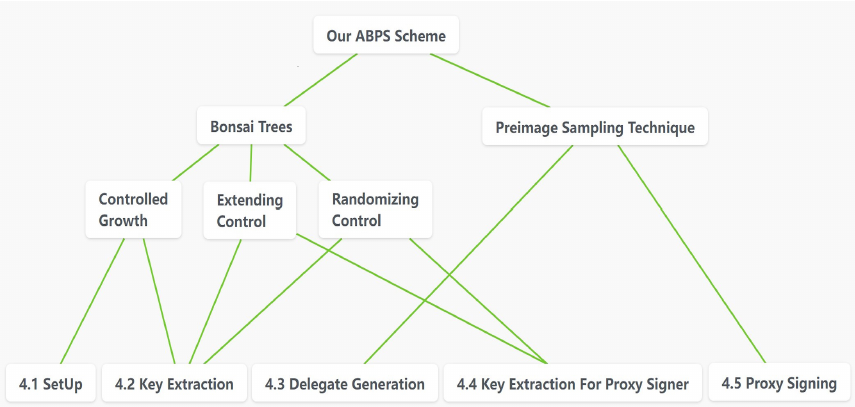
Figure 1. The framework of our